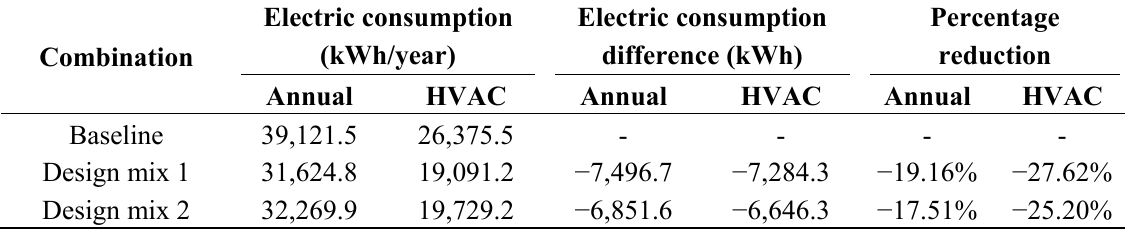
Table 10. Comparison of the electricity consumption, electric consumption difference and percentage reduction of the different